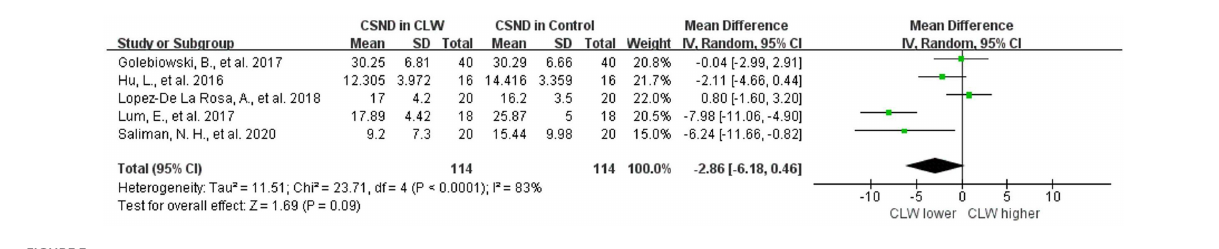
FIGURE3 Forest plot of CSND in CL wearer vs. control group. CI, confidence interval; IV, inverse variance; SD, standard deviation; CLW, contact lens wearers; CSND, corneal sub-basal nerve